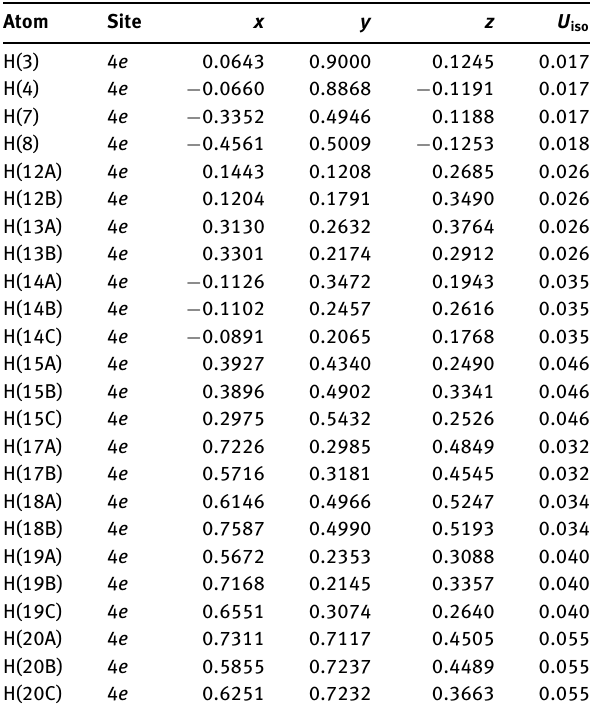
Table 2: Atomic coordinates and displacement parameters (in Å 2